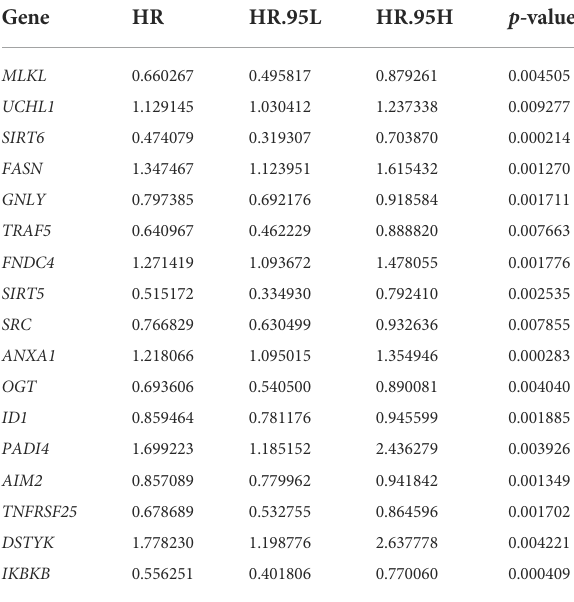
TABLE 1 Seventeen necroptosis-related genes associated with bladder cancer prognosis identi fi ed by univariate analysis. Gene